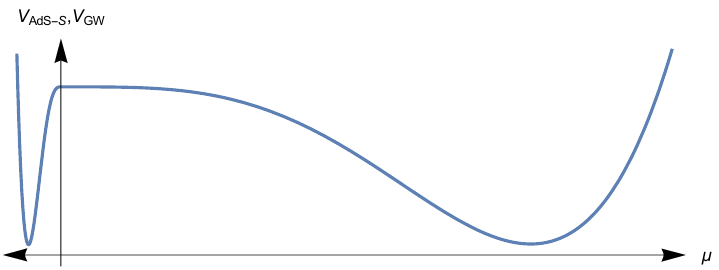
Figure 3 . Schematic plot of the combined potential for the AdS-Schwarzschild and Randall- Sundrum spaces, glued together at the origin and evaluated at the critical temperature.